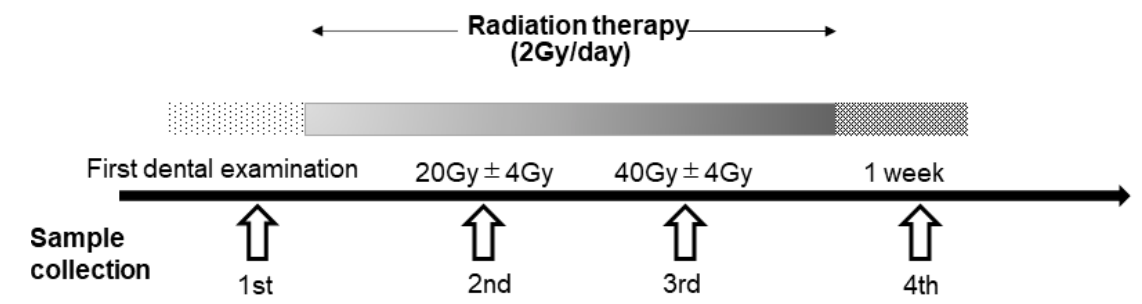
Figure 1. Flowchart of sample collection during radiation therapy. Saliva samples were collected at the following four time-points. (1) At the start of radiation therapy (from the first dental examination to the day before the start of irradiation), (2) during radiation therapy (irradiation dose of 20 Gy ± 2 days, first and second sessions; 8 days apart), (3) during radiation therapy (irradiation dose of 40 Gy ± 2 days, second and third sessions; 6 days apart) and (4) after completion of radiation therapy (from the end date to 1 week after the end).